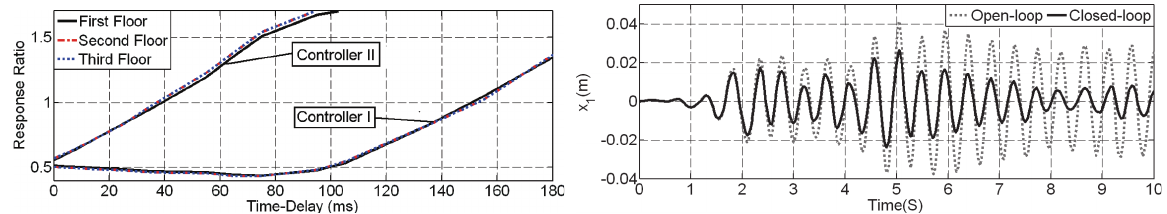
Fig. 12. Comparison of maximum response ratios x i max ( τ ) / x i max (0) vs time delay τ .